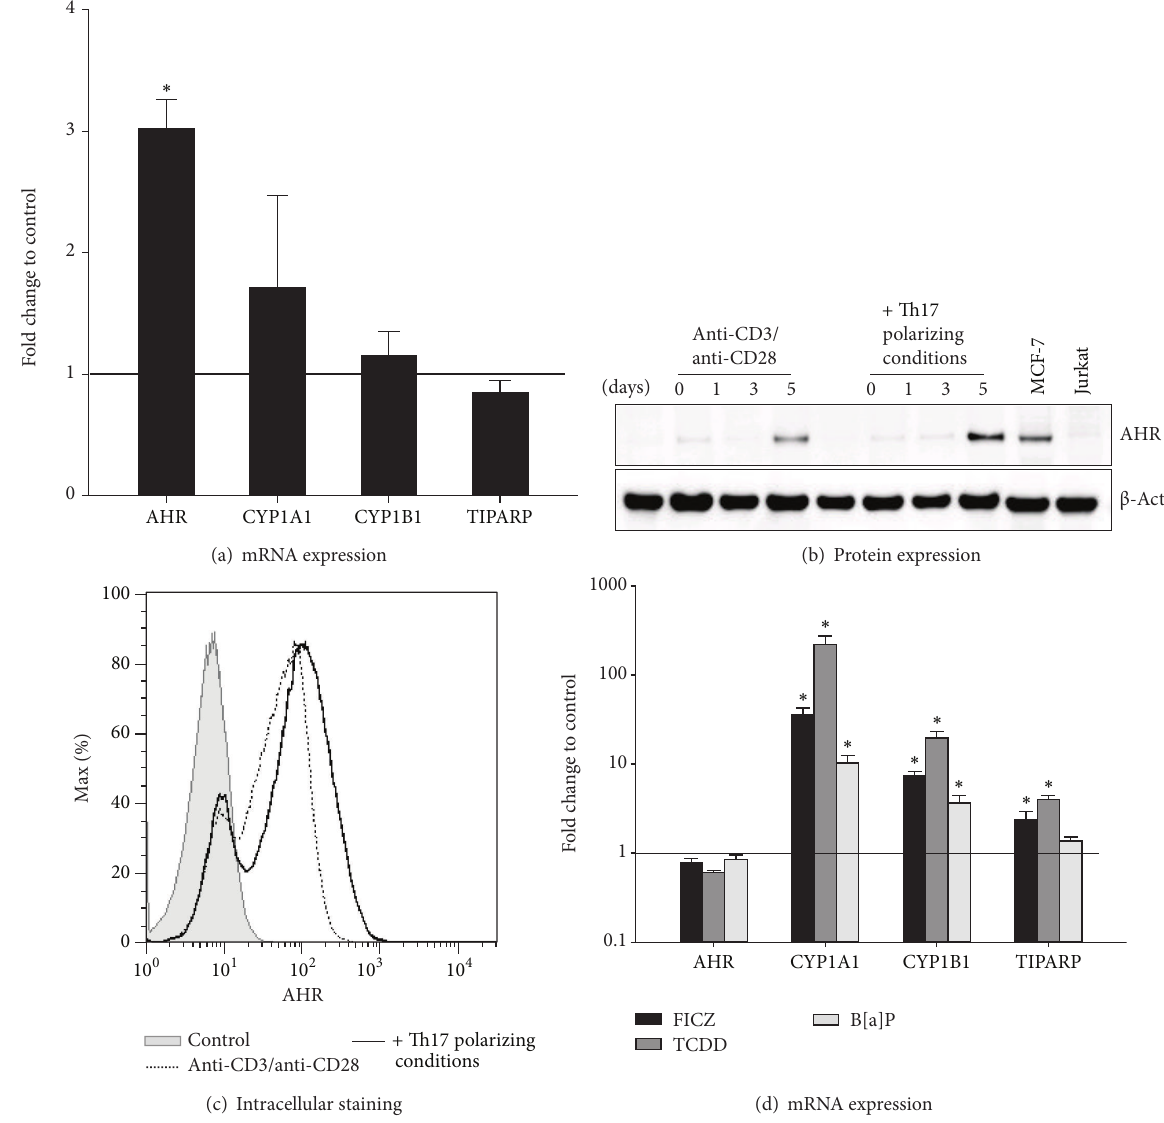
Figure 5: The AHR is induced in CD4 + T cells and activated by FICZ, TCDD, and B[a]P. Human CD4 + T cells were cultured with anti- CD3/anti-CD28 in the presence or absence of Th17 polarizing conditions for 5 days. (a) The mRNA expression of the indicated genes was measured by real-time PCR. Data were normalized to the mean of the reference genes GUSB, PPIA, PGK1, and the mRNA expression at day 0 using the ΔΔ Ct-method. Fold changes in gene expression of CD4 + T cells with Th17 polarizing conditions compared to control (black line) are represented as mean and SEM. ∗ represents significance, 𝑃 < 0.05 , Mann-Whitney 𝑈 test, and 𝑛 = 7 . (b) The AHR protein expression (94 kDa) at days 1, 3, and 5 of culture was measured by Western Blot analysis. The protein expression of unstimulated CD4 + T cells was used as control. Beta-Actin (42kDa) antibody was used as loading control. Cell lysates from MCF-7 cell line and Jurkat T cell line were used as AHR positive and negative control, respectively. One representative of 3 independent experiments is shown. (c) After restimulation with PMA, Ionomycin, and Monensin for 5 hours and fixation/permeabilization, the cells were stained for CD4 and AHR and analyzed by flow cytometry. Unstained cells were used as control 𝑛 = 2 . (d) The AHR ligands FICZ (100nM), TCDD (5 nM), and B[a]P (100nM) were added to CD4 + T cells cultured with Th17 polarizing cytokines. CD4 + T cells treated with anti-CD3/anti-CD28, Th17 polarizing conditions, and DMSO (0.05%) were used as control. Relative mRNA expression of the indicated genes was measured by real-time PCR and data were normalized to the mean of GUSB, PPIA, and PGK1 and to the mRNA expression at day 0 using the ΔΔ Ct-method. Data are shown as fold changes of mRNA expression in Th17 polarized and ligand treated CD4 + T cells compared to control (black line) and are represented as mean and SEM; ∗ represents significance, 𝑃 < 0.05 , Mann-Whitney 𝑈 test, and 𝑛 = 7